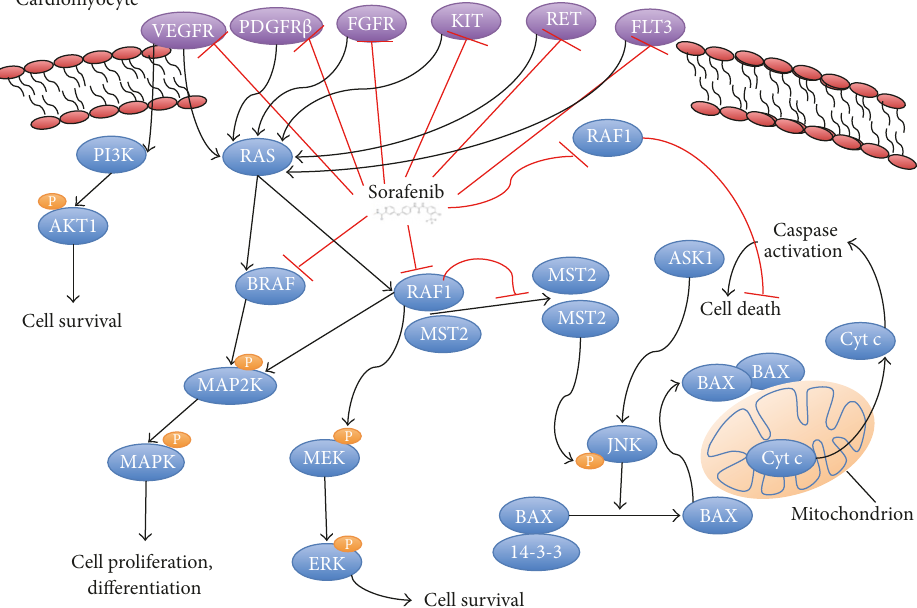
Figure 5: Sorafenib inhibits multiple tyrosine kinase and second messenger pathways. In the cardiac myocyte, inhibition of prosurvival pathways RAS/MAPK via BRAF and P13K/AKT1 via VEGFR leads to diminished survival. Sorafenib further inhibits RAF1, which leads to loss of tonic inhibition of cell death pathways and death through activation of